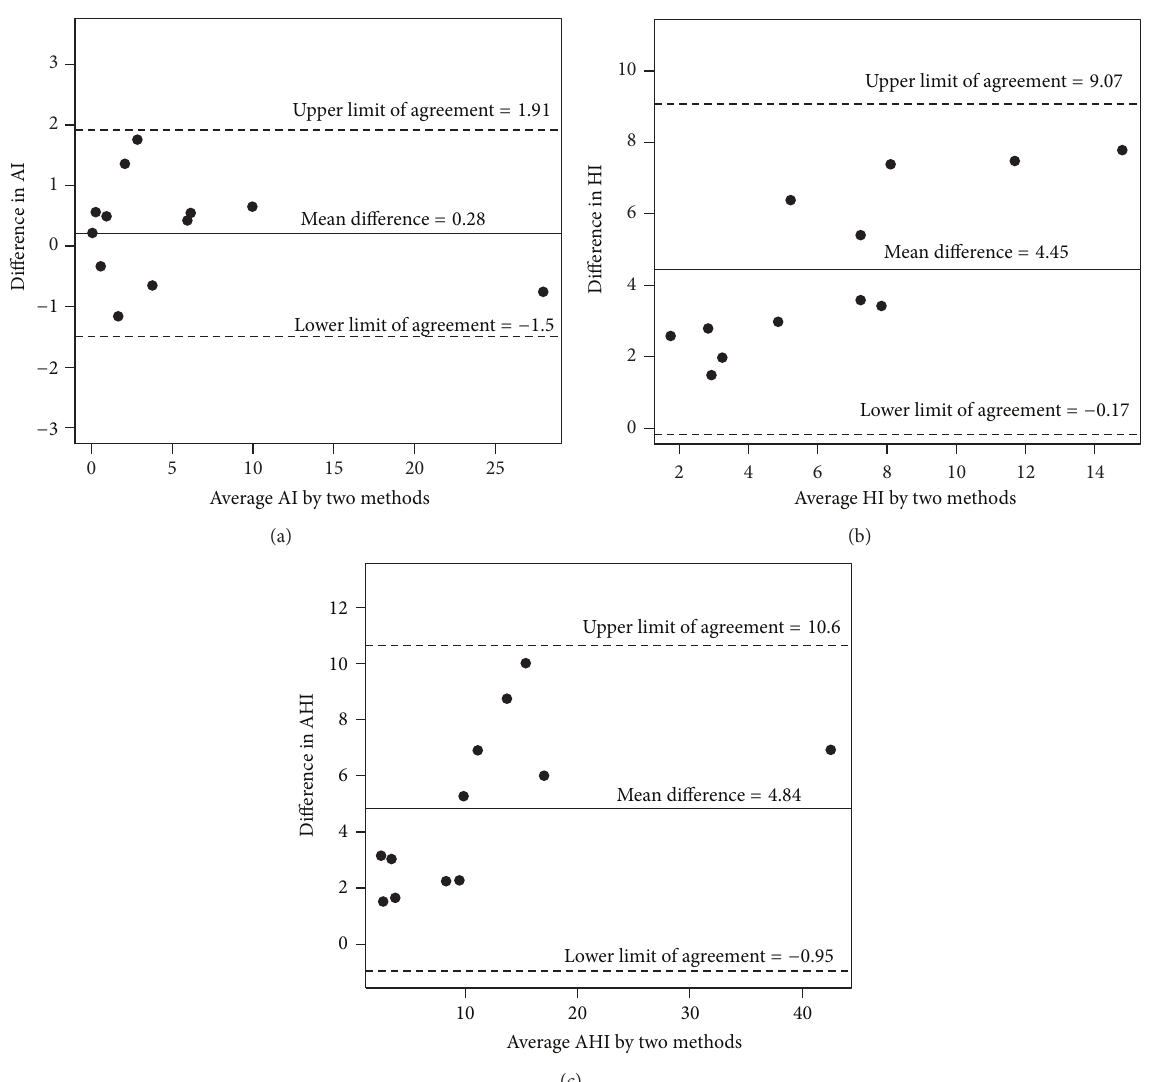
Figure 2: (a) Bland-Altman plot of PAP scoring versus manual scoring AI difference (PAP-scoring minus manual-scoring) by the mean. (b) Bland-Altman plot of PAP scoring versus manual-scoring HI difference (PAP scoring minus manual-scoring) by the mean. Note that all of the difference values were greater than 0, indicating that all PAP HI values were greater than the manual HI values. (c) Bland-Altman plot of PAP-scoring versus manual-scoring AHI difference (PAP scoring minus manual-scoring) by the mean. Note that all of the difference values were greater than 0, indicating that all PAP AHI values were greater than the manual AHI